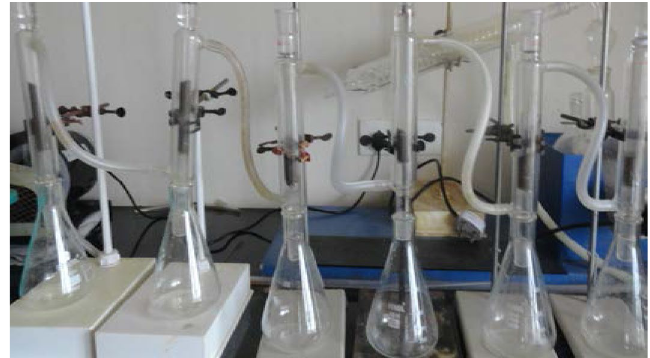
Figure 1. Experimental setup of the percolation reactor for nutrient